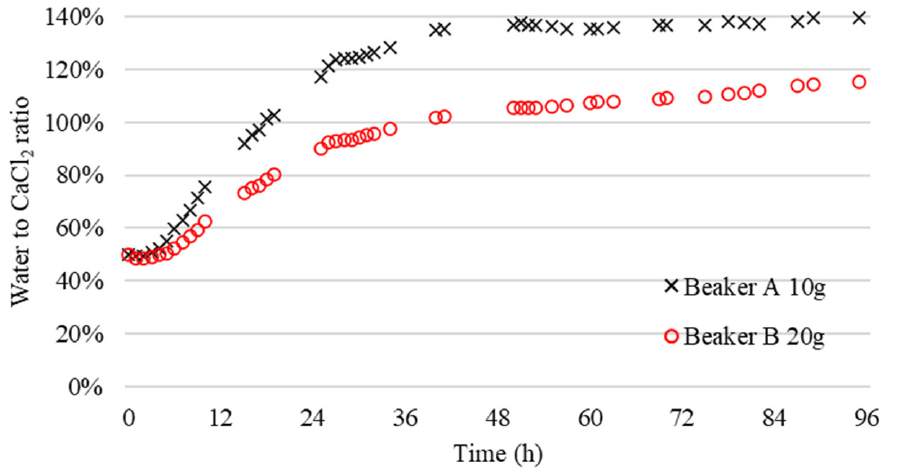
Figure 5. The effect of desiccant depth on CaCl 2 absorption.